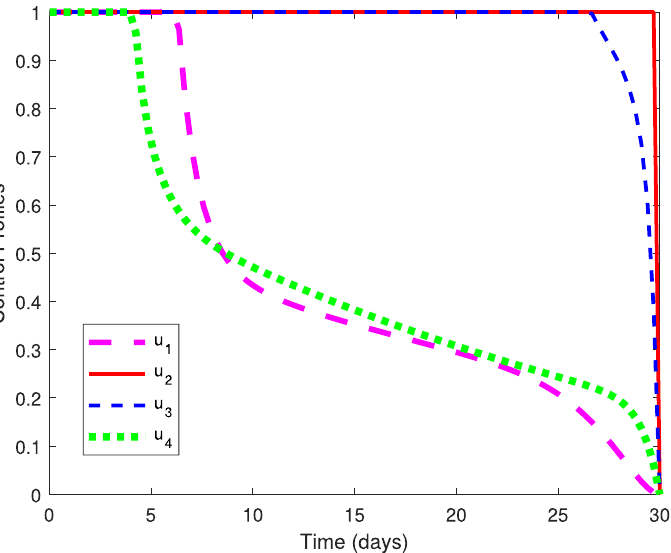
Figure 8. Illustration of optimal control profiles u ∗ 1 ( t ) , u ∗ 2 ( t ) , u ∗ 3 ( t ) and u ∗ 4 ( t ) for B 1 = B 2 = B 3 = 250 and B 4 = 1000